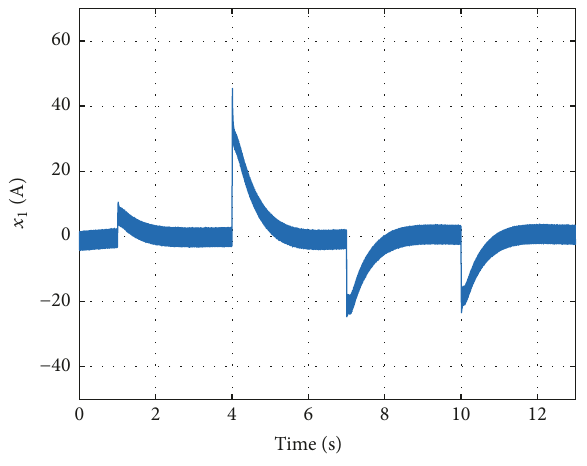
Figure 10: Supercapacitor current.